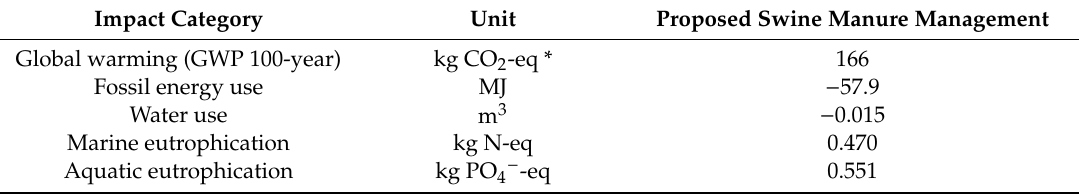
Table 6. Characterization of impacts for the proposed swine manure management scenario.